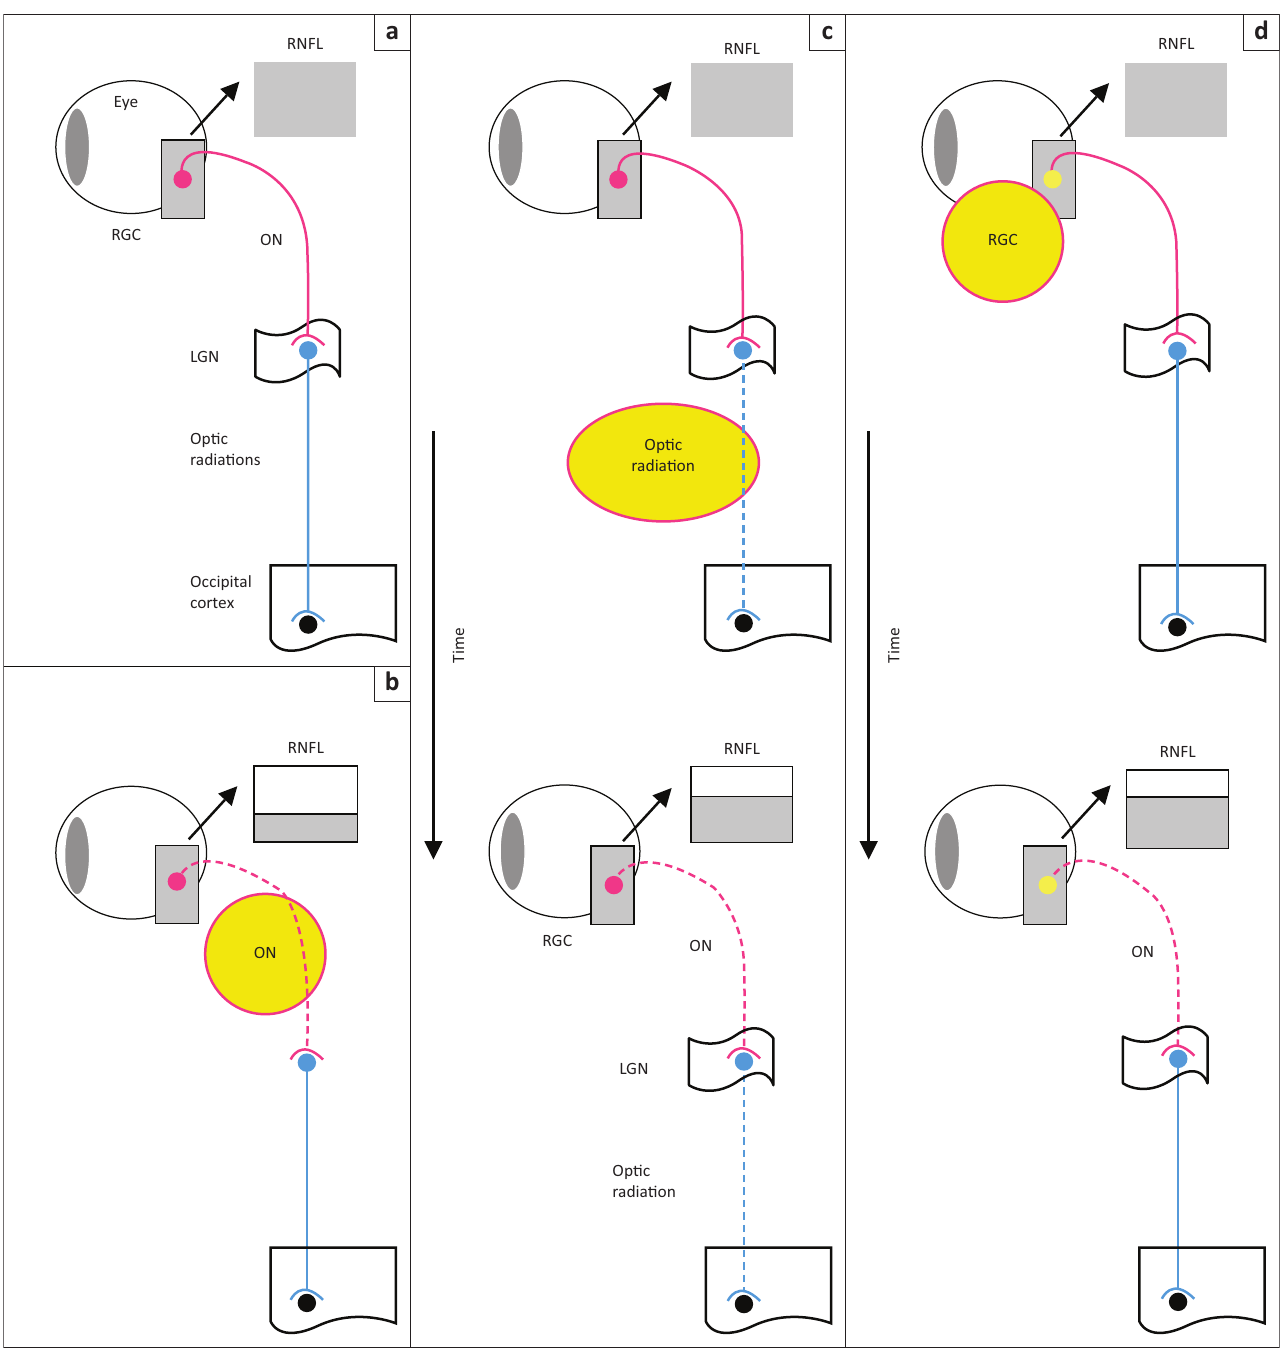
FIGURE 2: A model of the presumed relation between RNFL thickness and MS pathology: (a) A simplified sketch of the human visual pathway. RGCs send unmyelinated axons into the eye, where they form the RNFL (grey inlay), travel to the optic disc, and leave the orbit. Once the axons pass the sclera, they become myelinated and form the ON. After passing through the chiasma, where the temporal fibres cross (not shown), they are called the optic tract. The optic tract wraps around the midbrain and enters the LGN, where all these axons synapse. After the LGN, the axons fan out through the deep white matter (optic radiations) to reach the occipital cortex. (b) In MS, optic neuritis directly causes acute axonal loss in the ON (red dotted line), leading to thinning of the RNFL (small grey box). (c) MS lesions within the optic radiations (blue dotted line) do not immediately result in RNFL thinning. This outcome is thought to be a chronic consequence of trans-synaptic axonal loss through the LGN. With time, trans-synaptic axonal degeneration causes a smaller amount of axonal loss in the ON (red dashed line), with a quantifiable degree of RNFL loss (grey box). (d) Progressive loss of RGCs (yellow dot) is a probable result of chronic changes in the anterior visual pathways themselves in MS, and causes a small amount of RNFL loss (grey